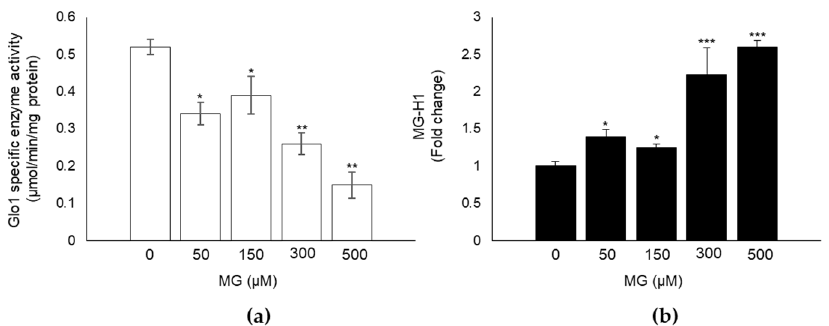
Figure 1. MG induces glycative stress in DPSCs. Exposure of cells to the indicated MG concentrations for 24 h induced a significant ( a ) inhibitory effect on Glo1 specific enzyme activity and ( b ) increase in MG-H1 intracellular levels. Histograms indicate the means ± SD of three different cultures, each of which was tested in triplicate. * p < 0.05, ** p < 0.01, and *** p < 0.001 compared with control untreated cells.